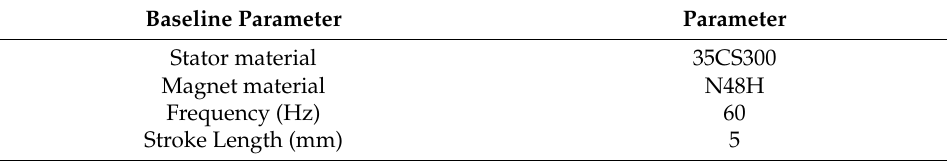
Table 3. Part mass of PMLA.